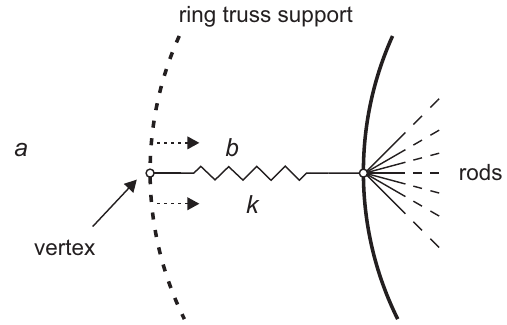
Figure 6. Displacement of the vertex due to the deformation of the flexible ring truss